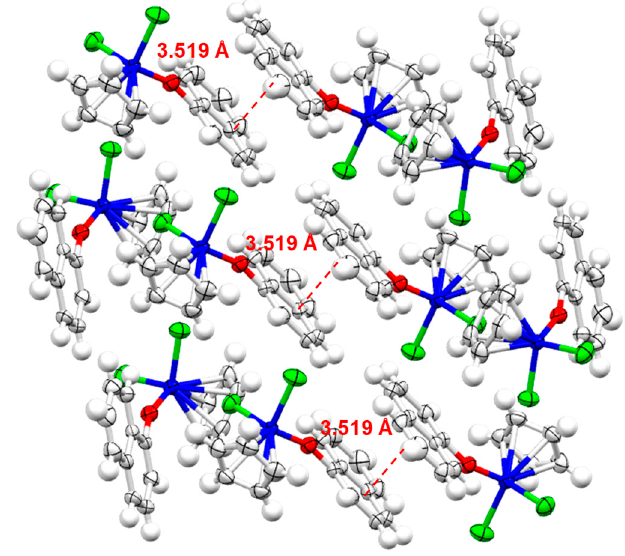
Figure 1. Single crystal structure of complex Ti1 (left); side-view of the π - π stacked dimer (upper right); top-view of the π - π stacked dimer (lower right, the two naphthalenyl rings were drawn in different color to give a clearer distinguishability). Selected bond length (Å) and angles (°): Ti1-Cl1, 2.2517(10), Ti1-Cl2, 2.2764(10), Ti1-O1, 1.7788(15), O1-C1, 1.365(2), Cl1-Ti1-Cl2, 102.53(5), O1-Ti1-